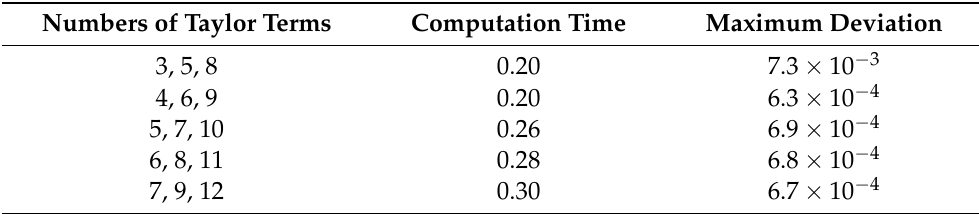
Table A1. Effect of the number of terms of Taylor expansion on the deviation and computation time.